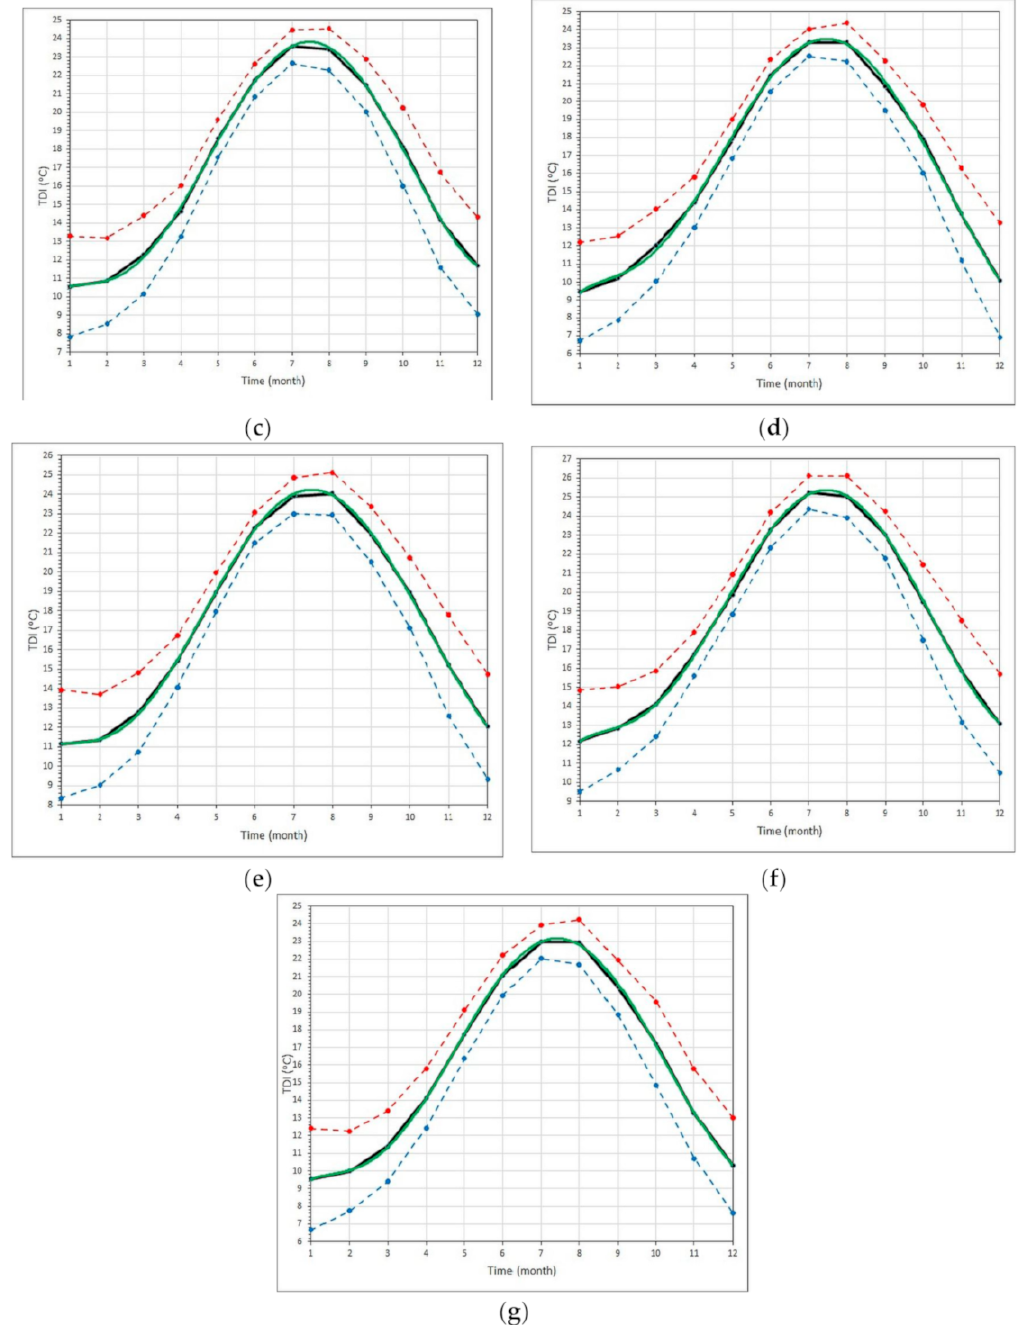
Figure 5. Intra-annual variation of the monthly mean TDIs in the epochs: ( a ) RCP 4.5 2021-2050, ( b ) RCP 4.5 2046–2075, ( c ) RCP 4.5 2071–2100, ( d ) RCP 8.5 2021–2050, ( e ) RCP 8.5 2046–2075, ( f ) RCP 8.5 2071–2100, and ( g ) historical 1985–2014. The black solid lines are the monthly means, the green solid curves are the best-fit polynomial lines to the means, and the red and blue dashed lines determine the upper and lower limits of the 95% confidence interval, respectively. Table 6 gives the equations of the best-fit polynomial lines; their extremely high R 2 (approximately equal to 1) imply an excellent fit to the calculated intra-annual TDI